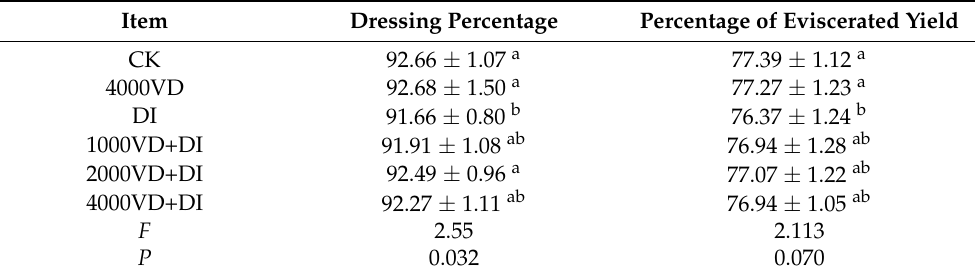
Table 3. Slaughter performance of the Wenchang chicken (%).